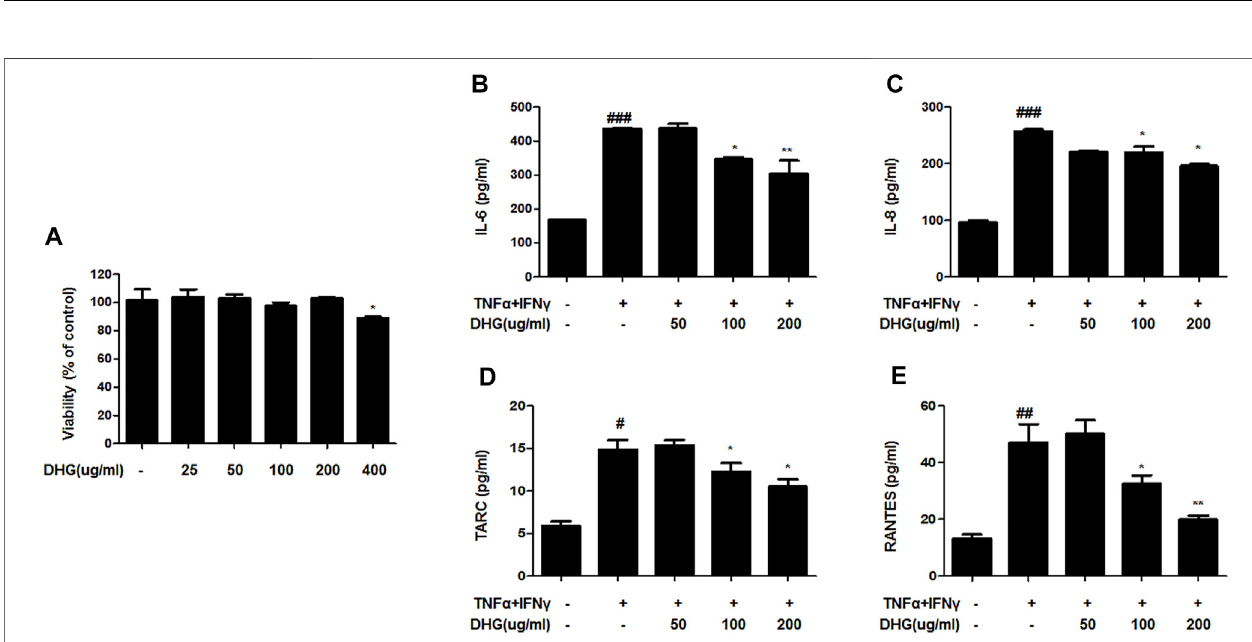
Frontiers in Pharmacology |